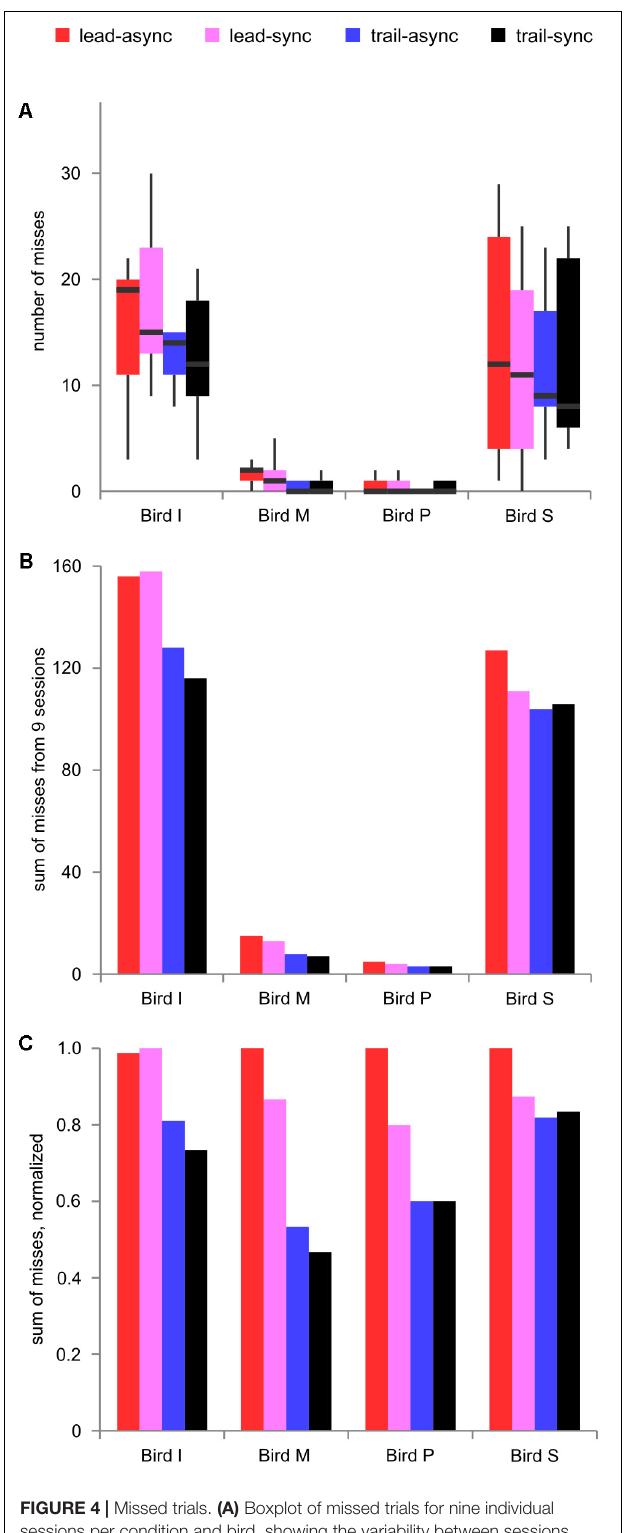
FIGURE 4 | Missed trials. (A) Boxplot of missed trials for nine individual sessions per condition and bird, showing the variability between sessions. (B) Sum of missed trials across nine sessions and (C) normalized sum of missed trials, for each bird tested in each condition. Color coding as in Figure 2